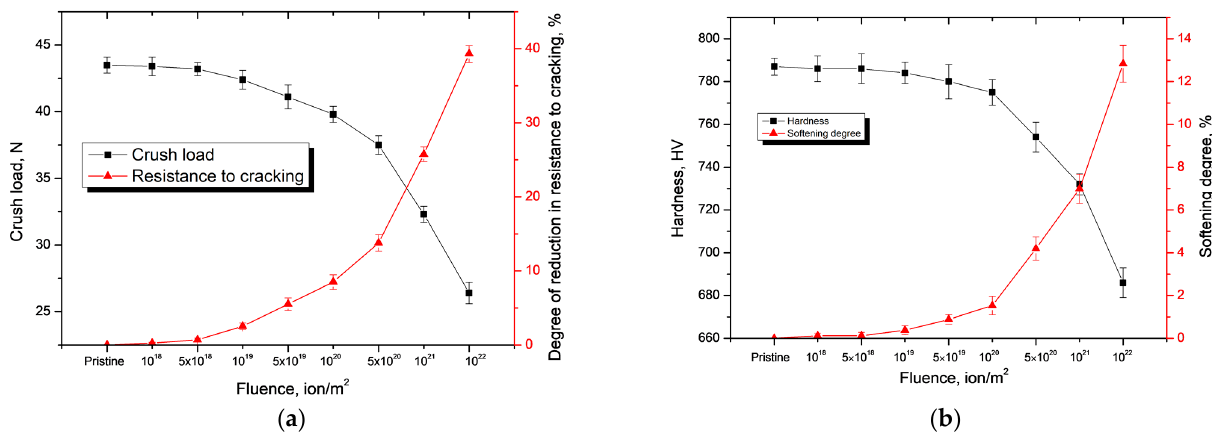
Figure 6. ( a ) The dependence of the change in the values of resistance to cracking of ceramics under an external load; ( b ) the change in hardness and softening degree of ceramics depending on the irradiation